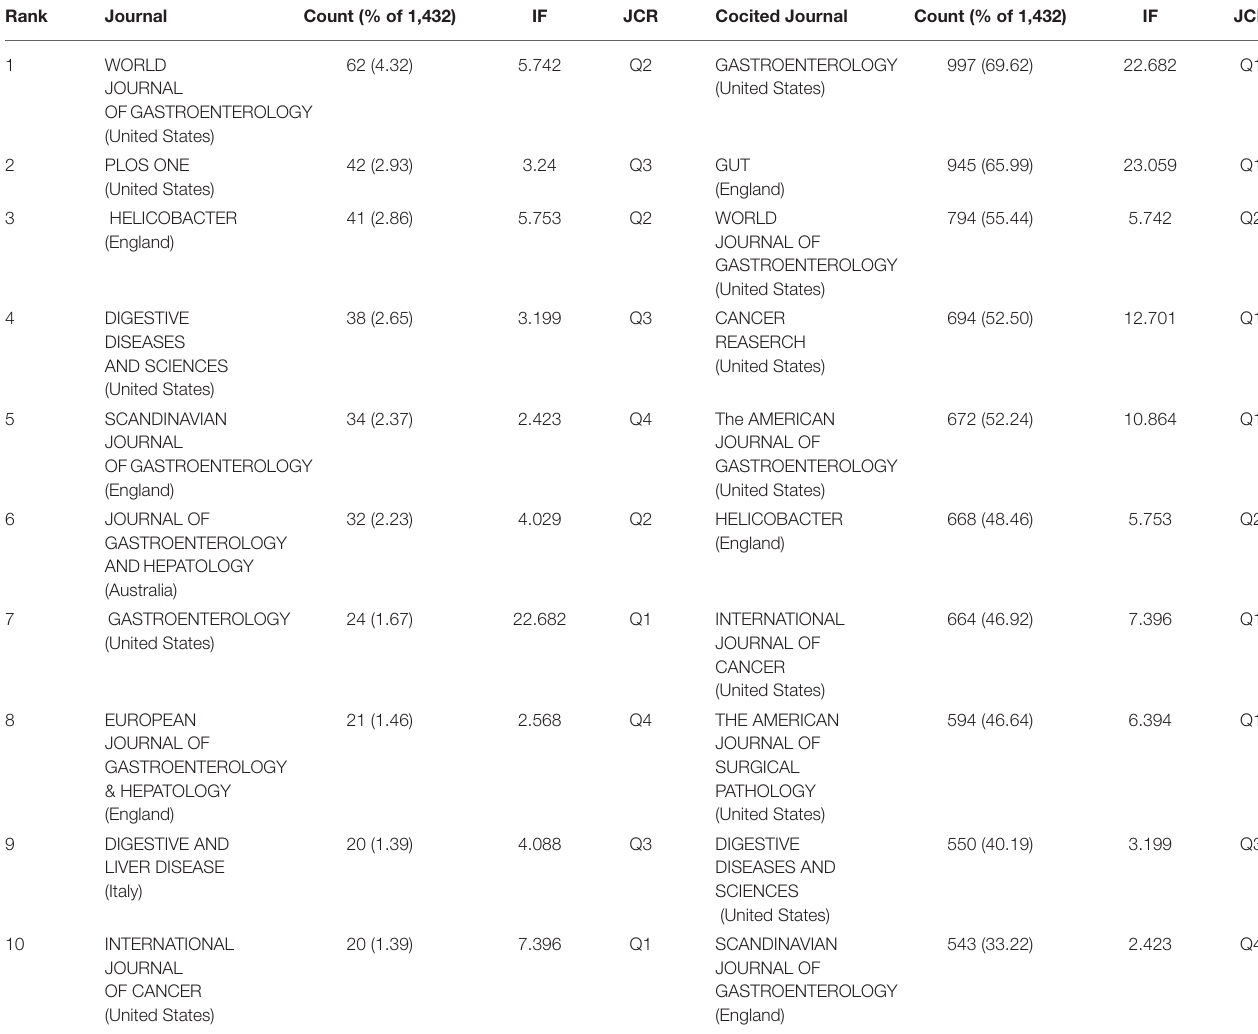
TABLE 3 | Top 10 journals and co-cited journals in AG